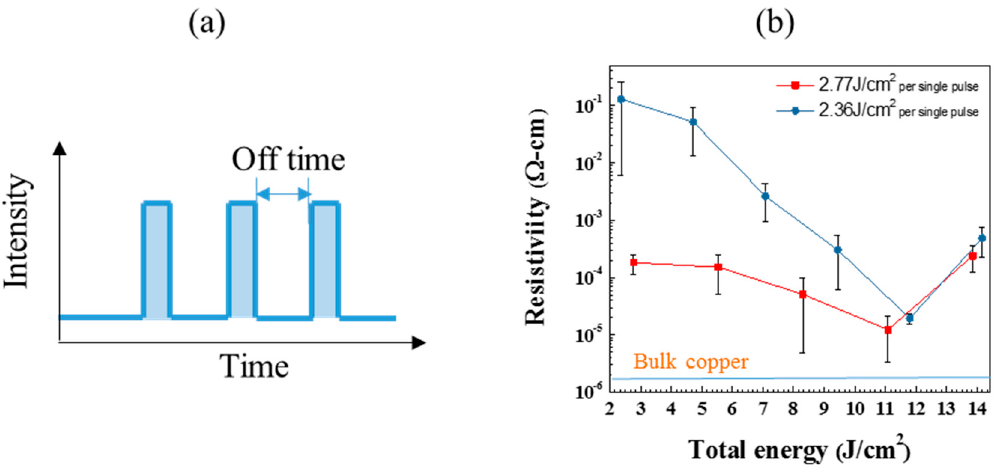
Figure 4. ( a ) Schematic diagram for multiple pulse IPL. The total area of pulses is defined as the total energy. ( b ) Resistivity of copper film sintered by multiple pulses. An off time of 2 s is used between IPL pulses.